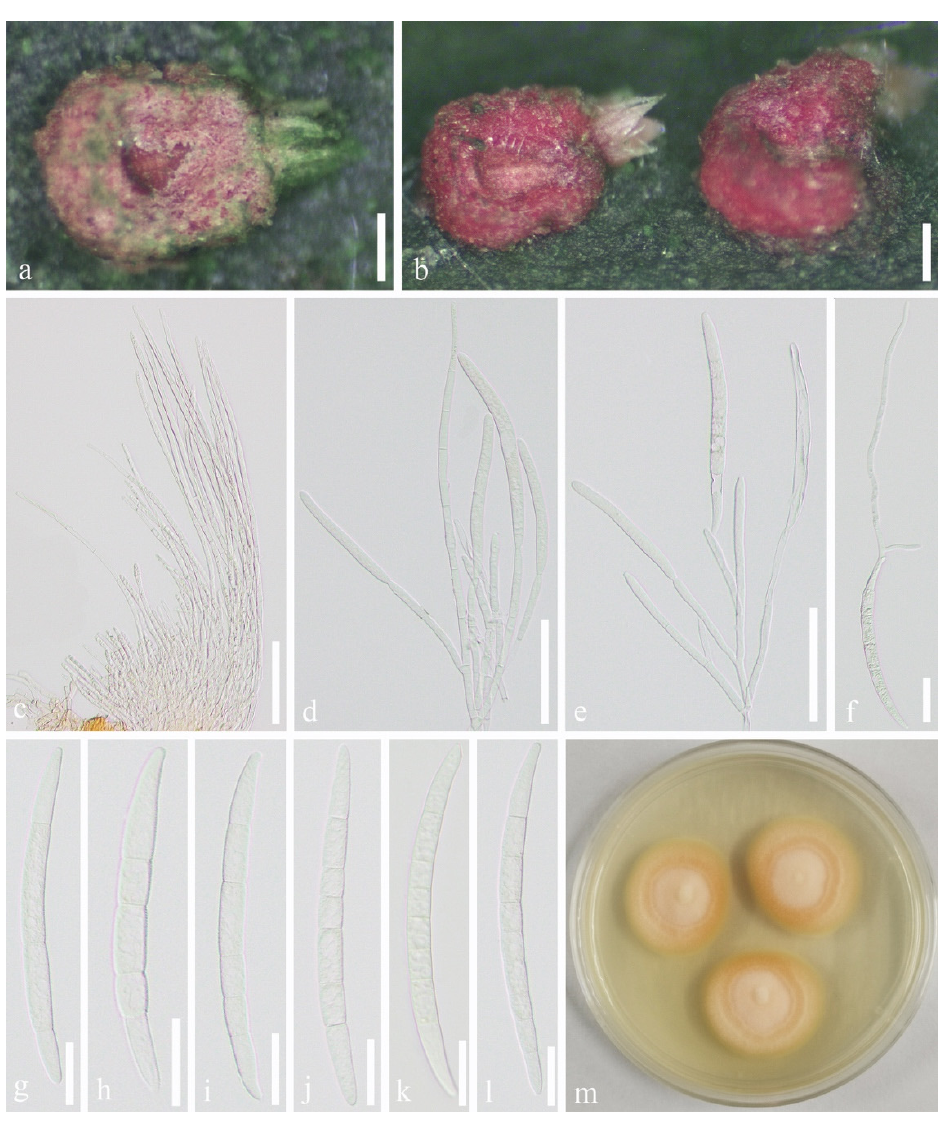
Figure 6. Microcera kuwanaspidis (SICAU 21-0006, holotype). ( a , b ) Stromata and sporodochia on host substrate. ( c – e ) Conidiophore with developing macroconidia. ( f ) Germinated conidium. ( g – l ) Macroconidia. ( m ) Colonies on PDA after 12 days. Scale bars: ( a , b ) 200 μ m, ( c – e ) 50 μ m, ( f – l ) 20 μ m.